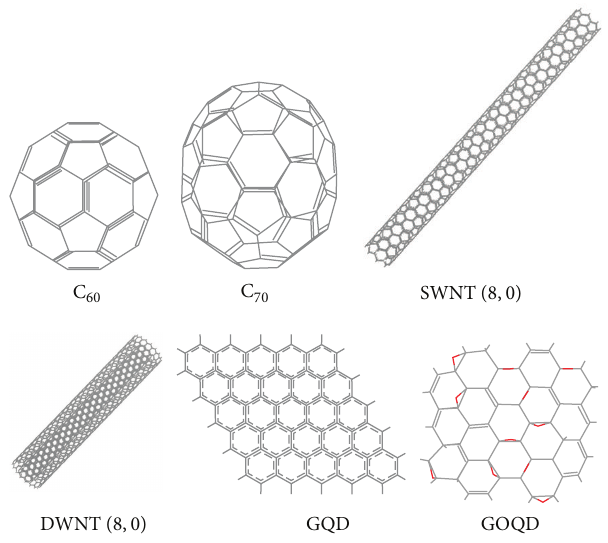
Figure 1: Schematic diagram showing the studied carbon nanopar-